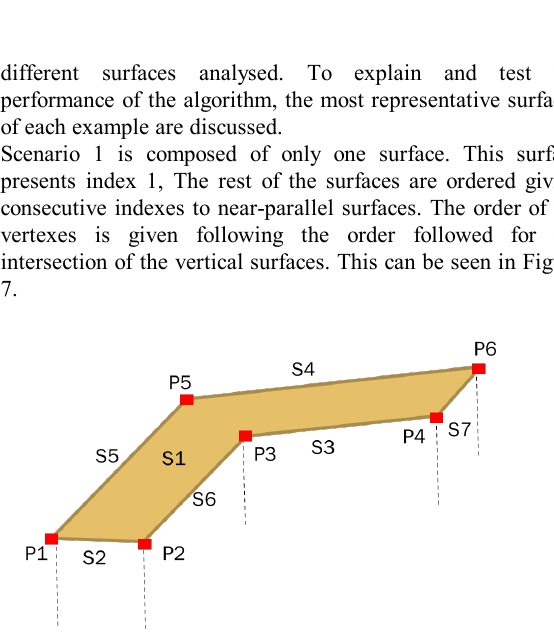
Figure 7. Schema of vertexes and surfaces for Scenario 1 Thus, as input data the algorithm has three different structures: